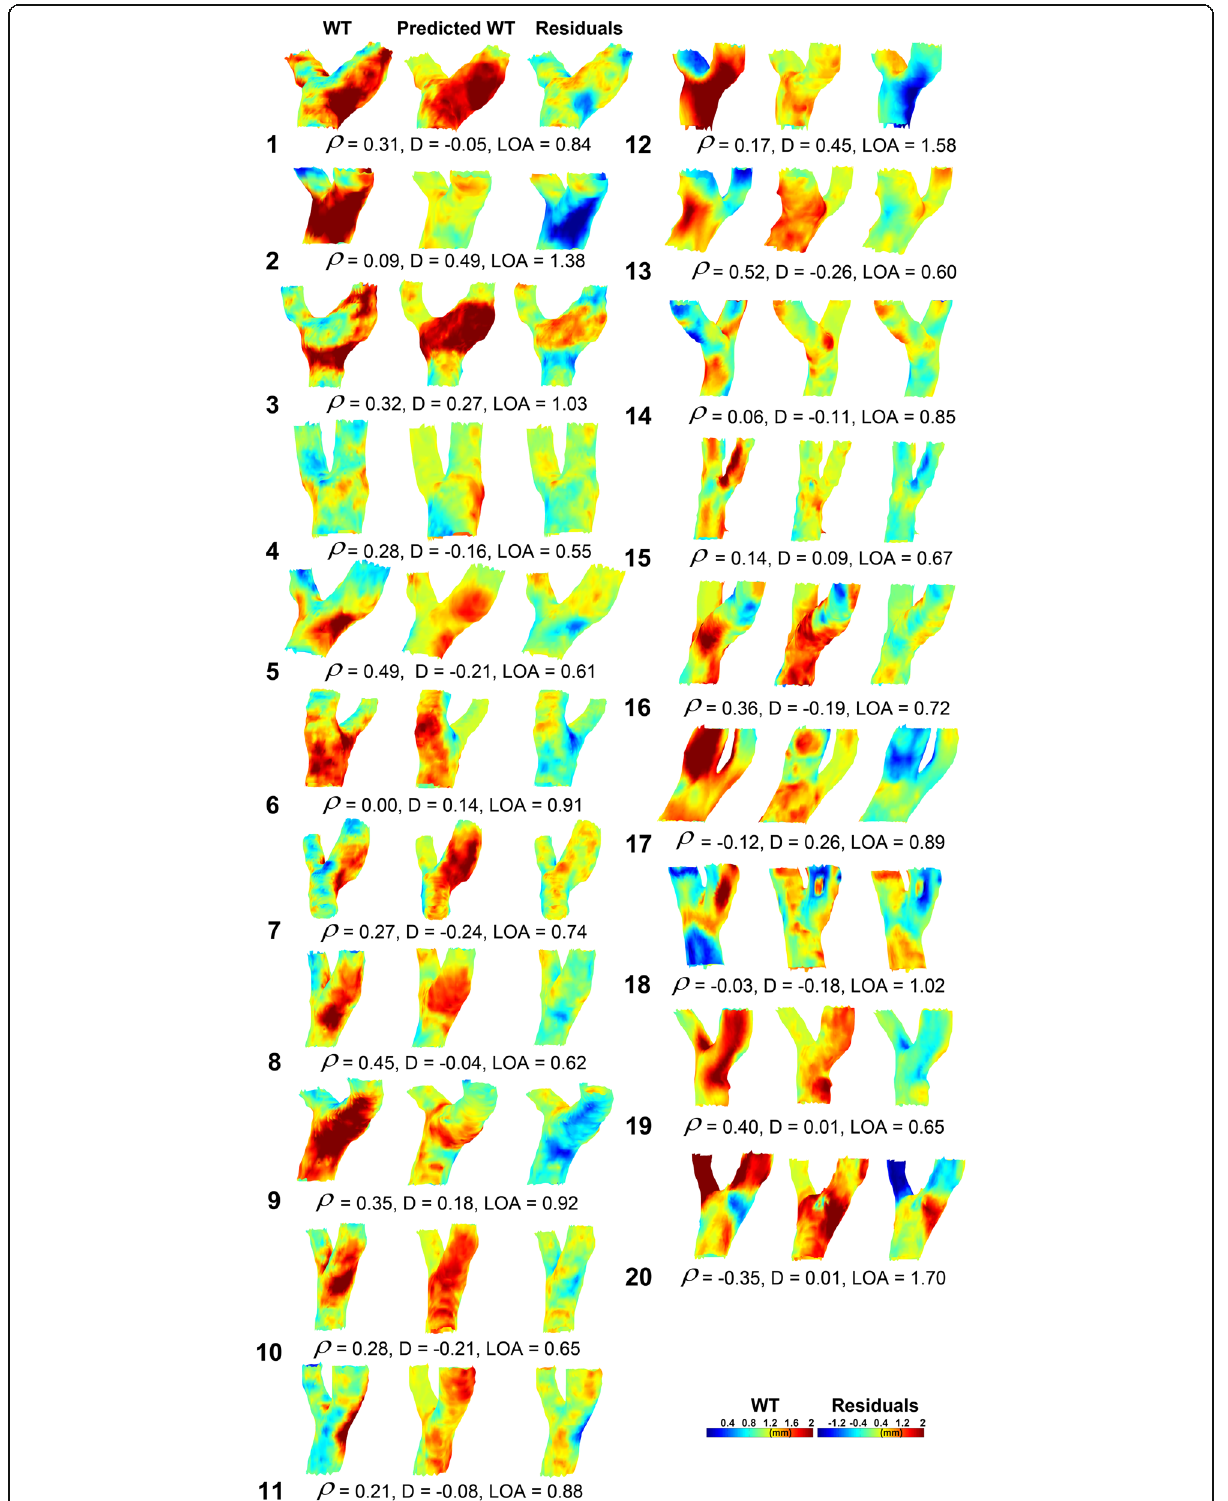
Fig. 5 The predicted WT maps ( center column ) based on linear regression of the cohort-averaged WT, WSS and diameter maps compared to the original WT maps ( left column ). The right column shows the 3D residual maps. Spearman ’ s ρ is given. D and LOA represent the difference and limits of agreement from the Bland-Altman